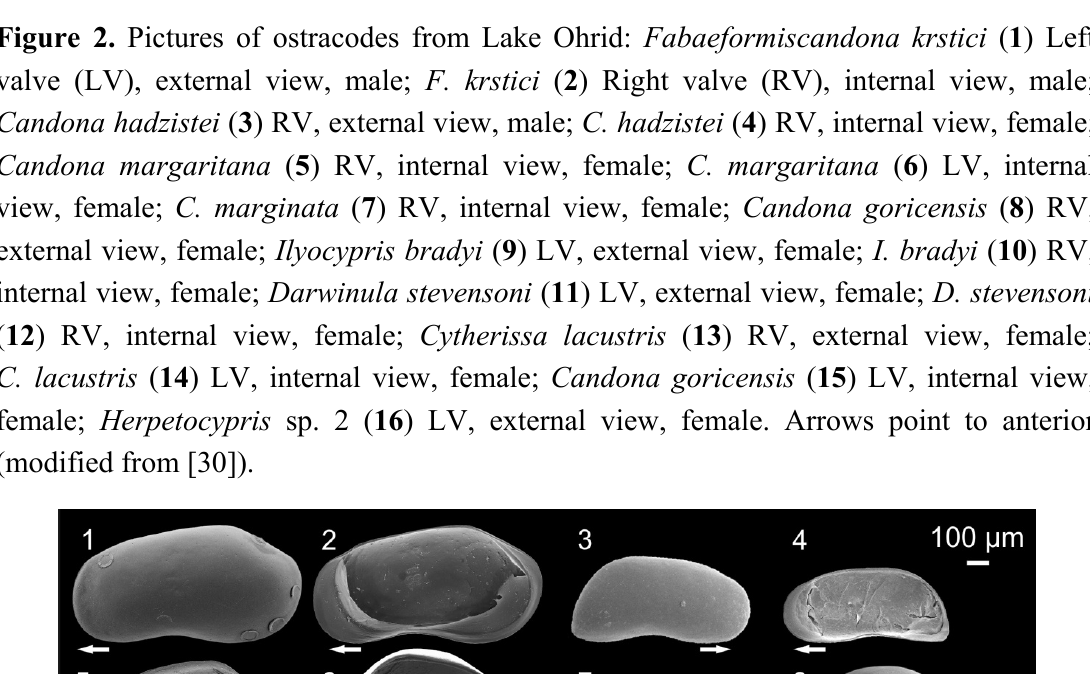
Figure 2. Pictures of ostracodes from Lake Ohrid: Fabaeformiscandona krstici ( 1 )